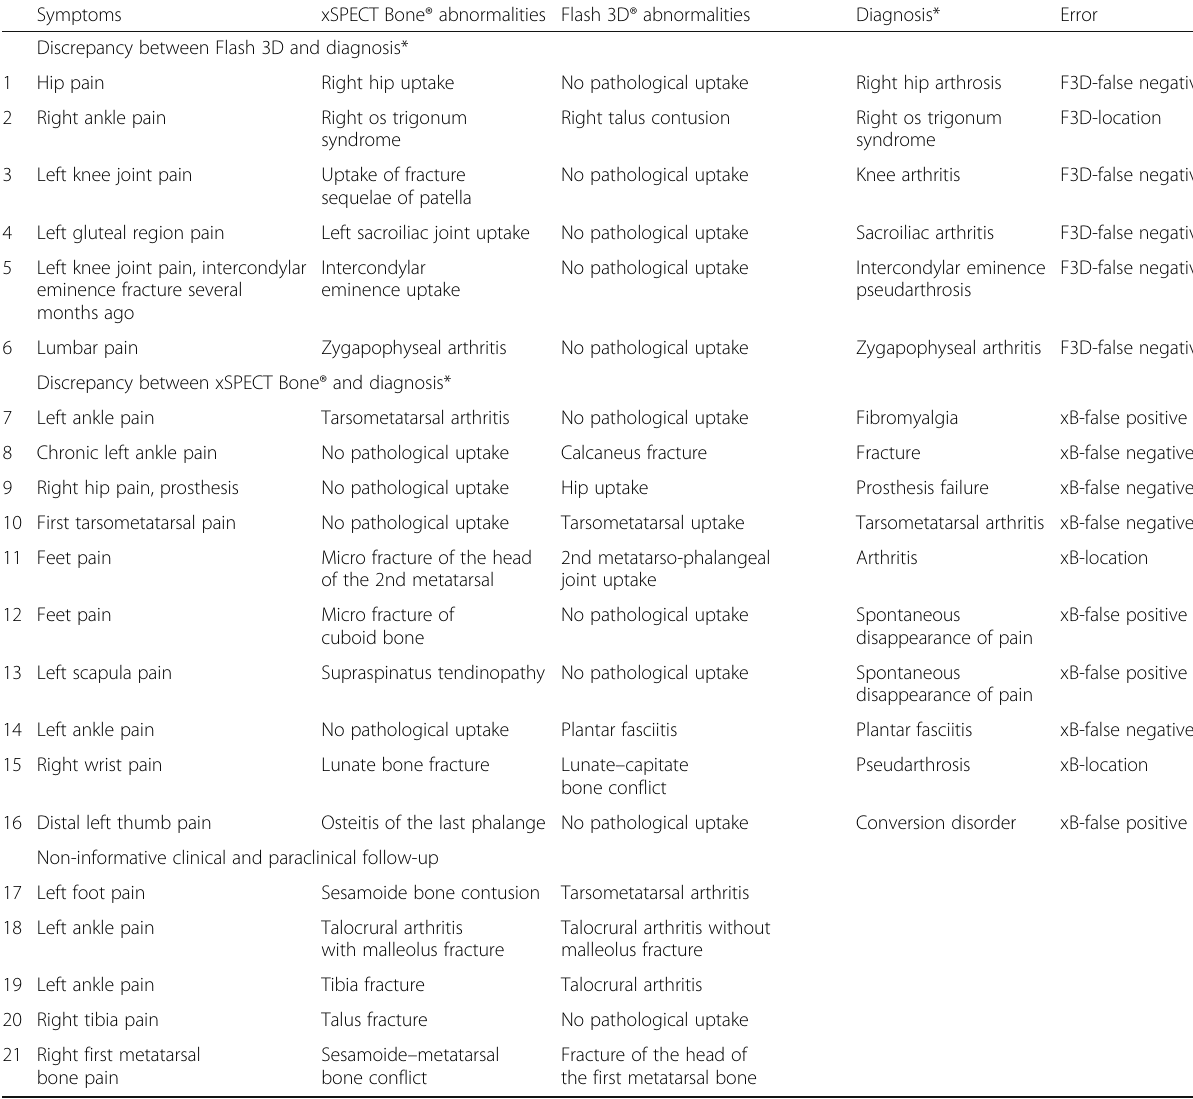
Table 6 Inter-reconstruction diagnostic discrepancy Symptoms xSPECT Bone® abnormalities Flash 3D® abnormalities Diagnosis* Error Discrepancy between Flash 3D and